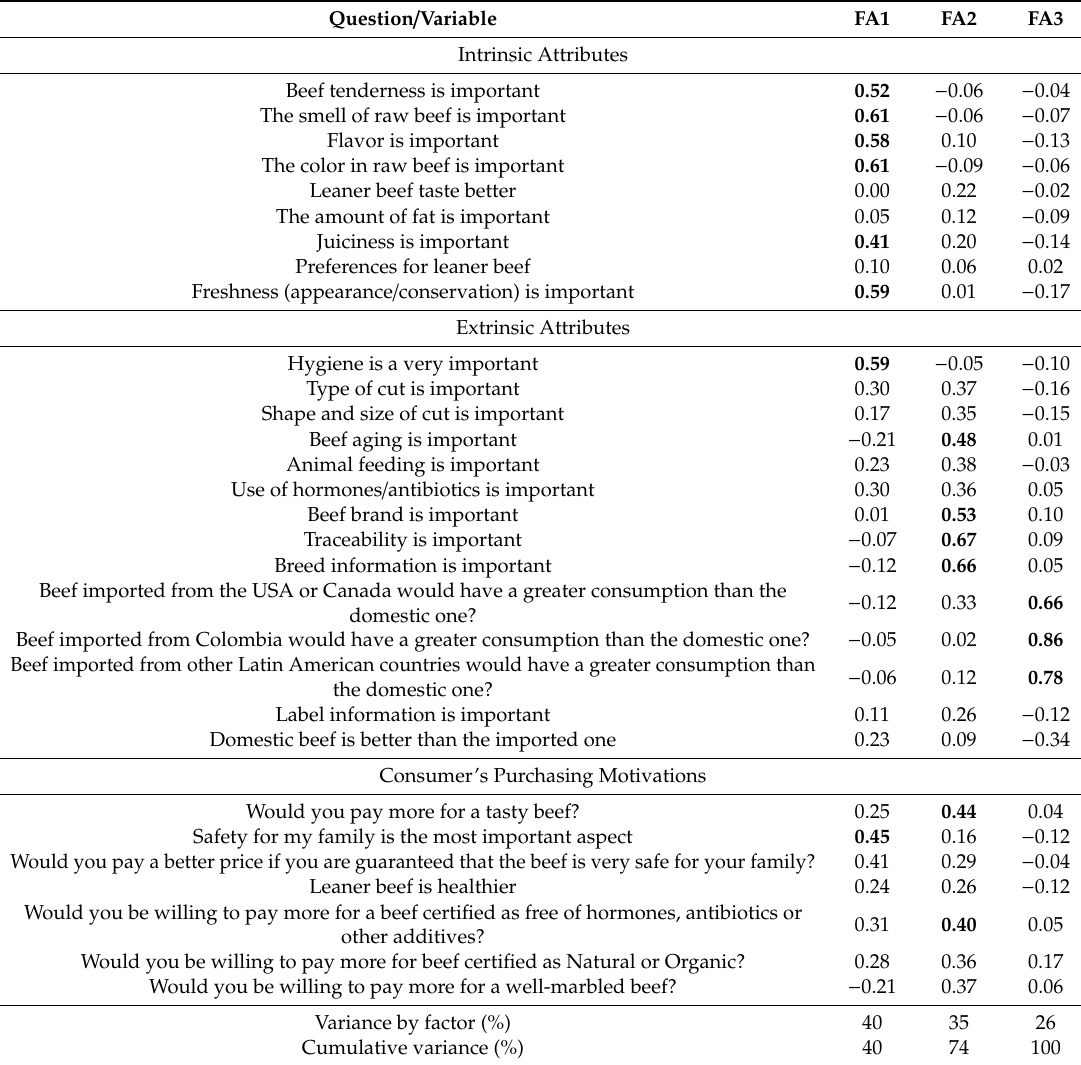
Table 3. Results of the confirmatory factorial analysis for questions addressing intrinsic attributes, extrinsic attributes, and consumer purchasing